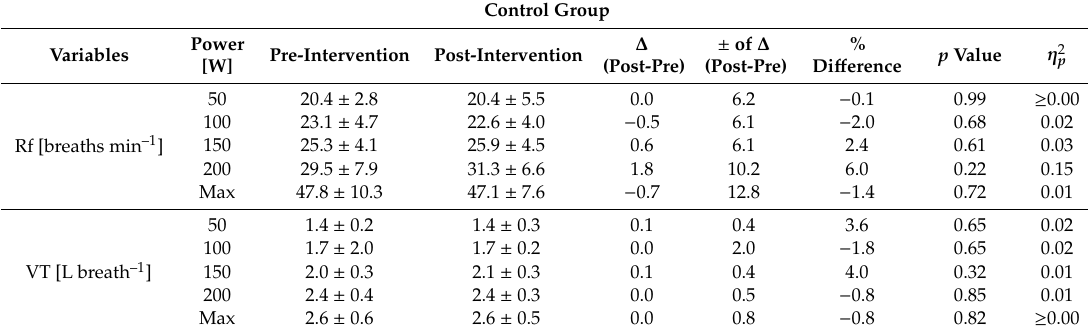
Table 3. Pre- and postintervention within-group comparisons (Rf, VT, VE, VO 2 max). Control